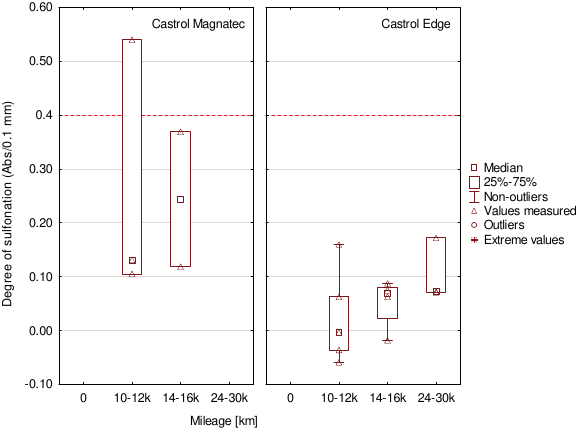
Fig. 7. The degree of sulfonation of the engine oils tested The test results show that all of the Castrol Edge 5W30 oil samples were below the assumed maximum limit (0.4 Abs/0.1 mm), whereas in the group of Castrol Magnatec 10W40 oils – one sample exceeded the limit value (CMG03 – 0.54 Abs/0.1 mm). The last parameters tested were water (Fig. 8) and gly- col content (Fig. 9). The presence of water in engine oil adversely affects the corrosion protection and leads to oil degradation. Too high water content may indicate leaks in the lubrication system, defects or leaks in water separators, or leakage from the cooling system. Upon analyzing the